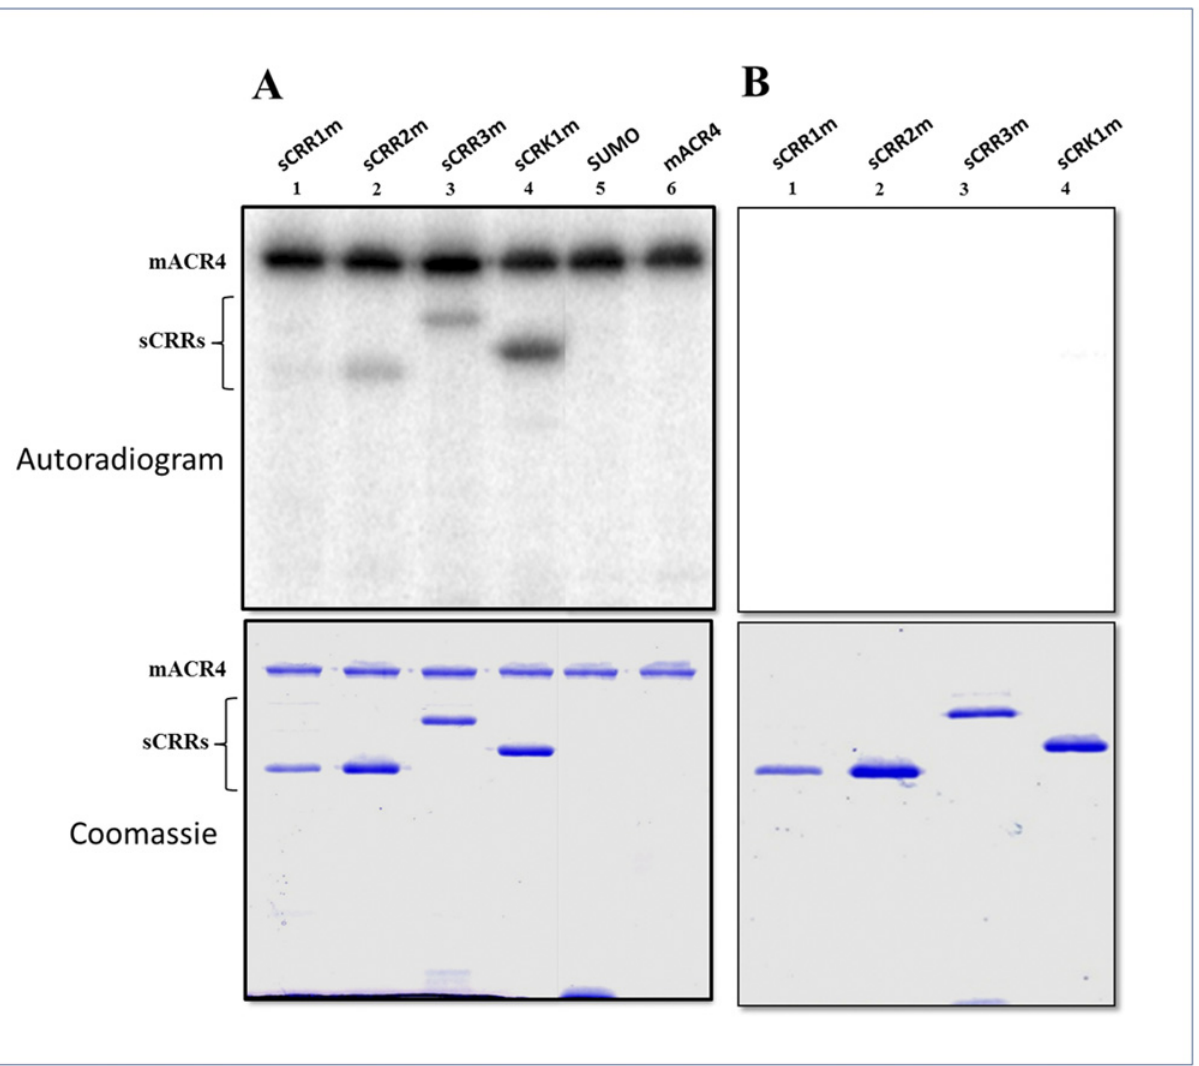
Fig 3. ACR4 can phosphorylate the ICDs of the CRRs. Active mACR4 was incubated with the inactive sCRRs in an in vitro kinase assay. (A) Upper panel shows an autoradiogram demonstrating ACR4 can phosphorylate the ICDs of the inactive CRRs. ACR4 cannot phosphorylate the SUMO tag. Lower panel shows the corresponding coomassie stained gel. (B) Upper panel depicts an autoradiogram showing the inactivity of the sCRR mutants in which their respective catalytic Asp residues have been mutated to Ala. Lower panel is the corresponding coomassie stained gel showing the presence of each